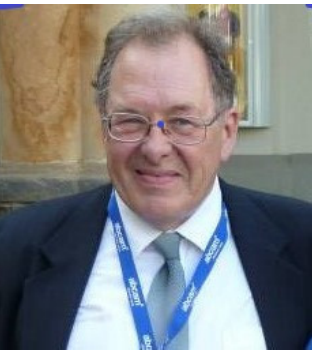
Figure 2. Robert B. Sim, 1951–2021 (Courtesy of Wilhelm Schwaeble, Cambridge) Both were the bricks and mortar of two complement focused Medical Research Council (MRC) Units in England: Bob as senior staff scientist of the MRC Immunochemistry Unit in Oxford (under its brilliant directors Nobel laureate Rodney Porter and Kenneth B.M. Reid), which also housed other world leading scientists including Duncan Campbell, Alex Law and Tony Day, and Peter as director of the Cambridge-based MRC Molecular Immunopathology Unit with Mike Hobart and Dick Harrison as staff scientists. Both MRC Units were centres of excellence at national and international levels and many complementologists had the opportunity to visit these places as invited seminar speakers,